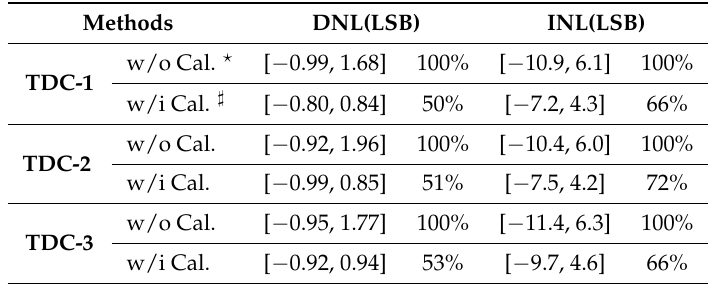
Figure 7. Measured DNL and INL values for the triple-TDC and TDL-TDC. Table 2. INL and DNL for the proposed triple-TDC with